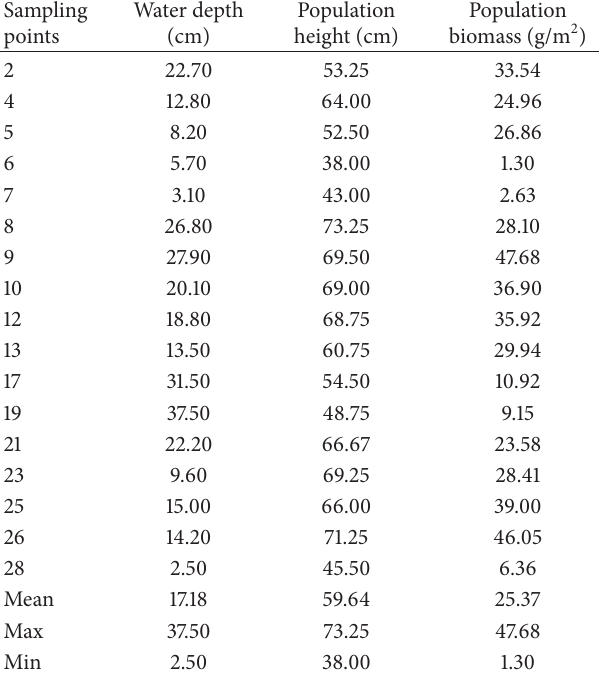
Table 1: The statistical description of Carex lasiocarpa community in different sampling